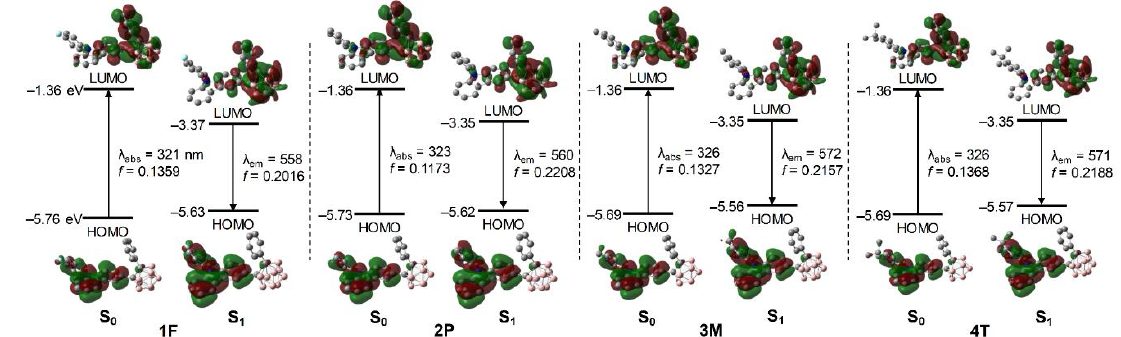
Figure 4. Frontier molecular orbitals for 1F , 2P , 3M , and 4T in the ground state (S 0 ) and first excited singlet state (S 1 ) with